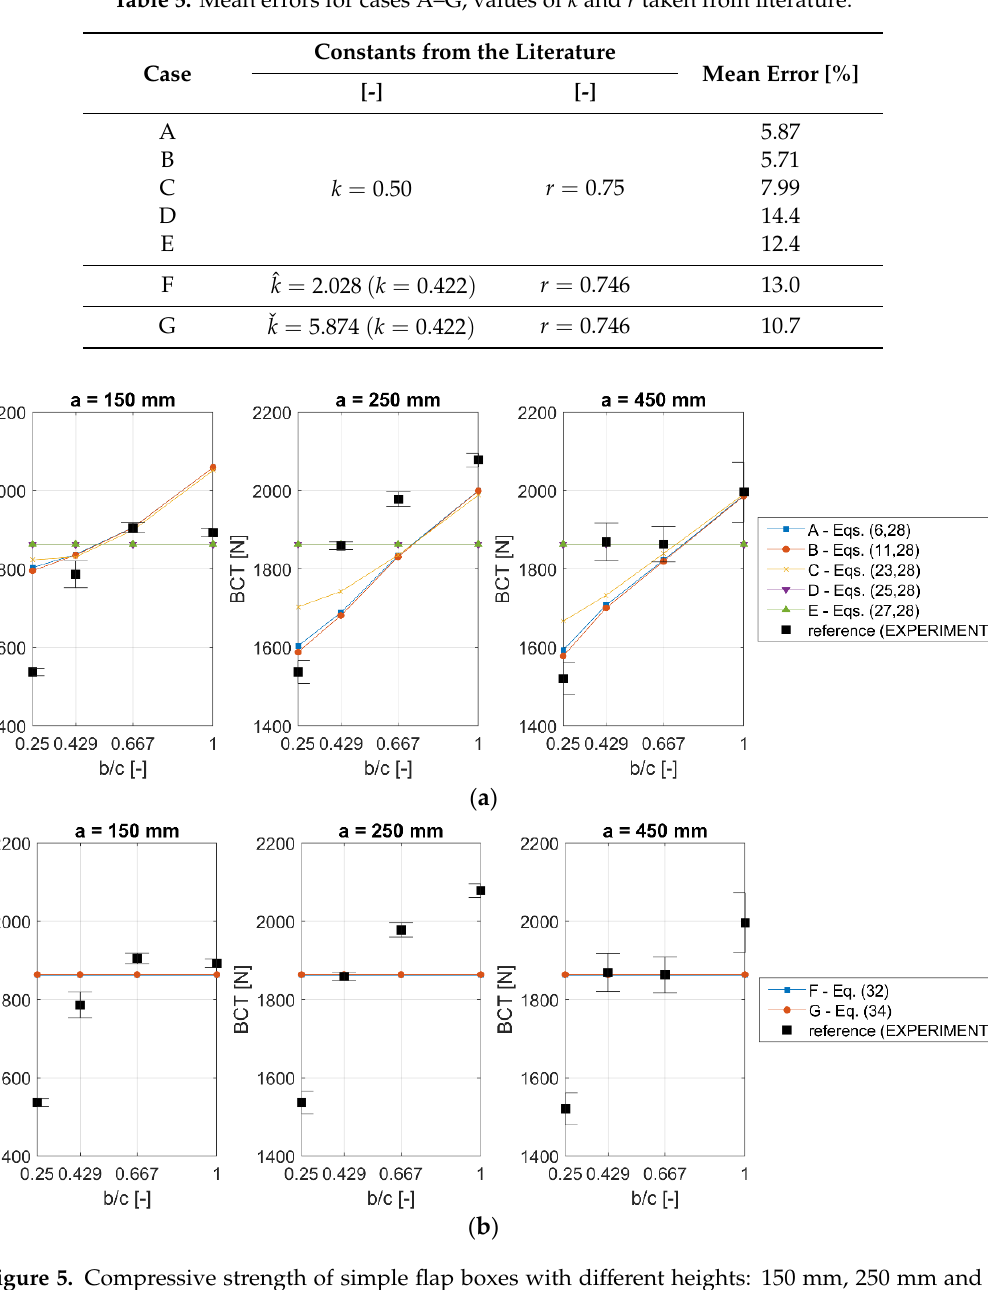
Table 5. Mean errors for cases A–G; values of k and r taken from literature.